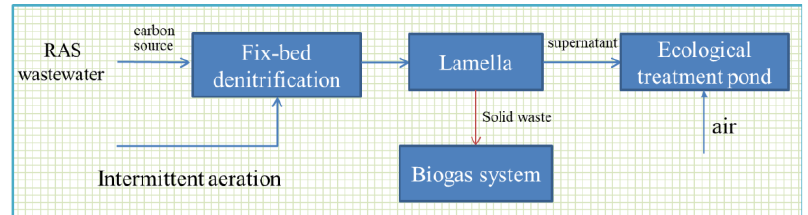
Figure 6. Combined fixed-bed denitrification and ecological treatment system.